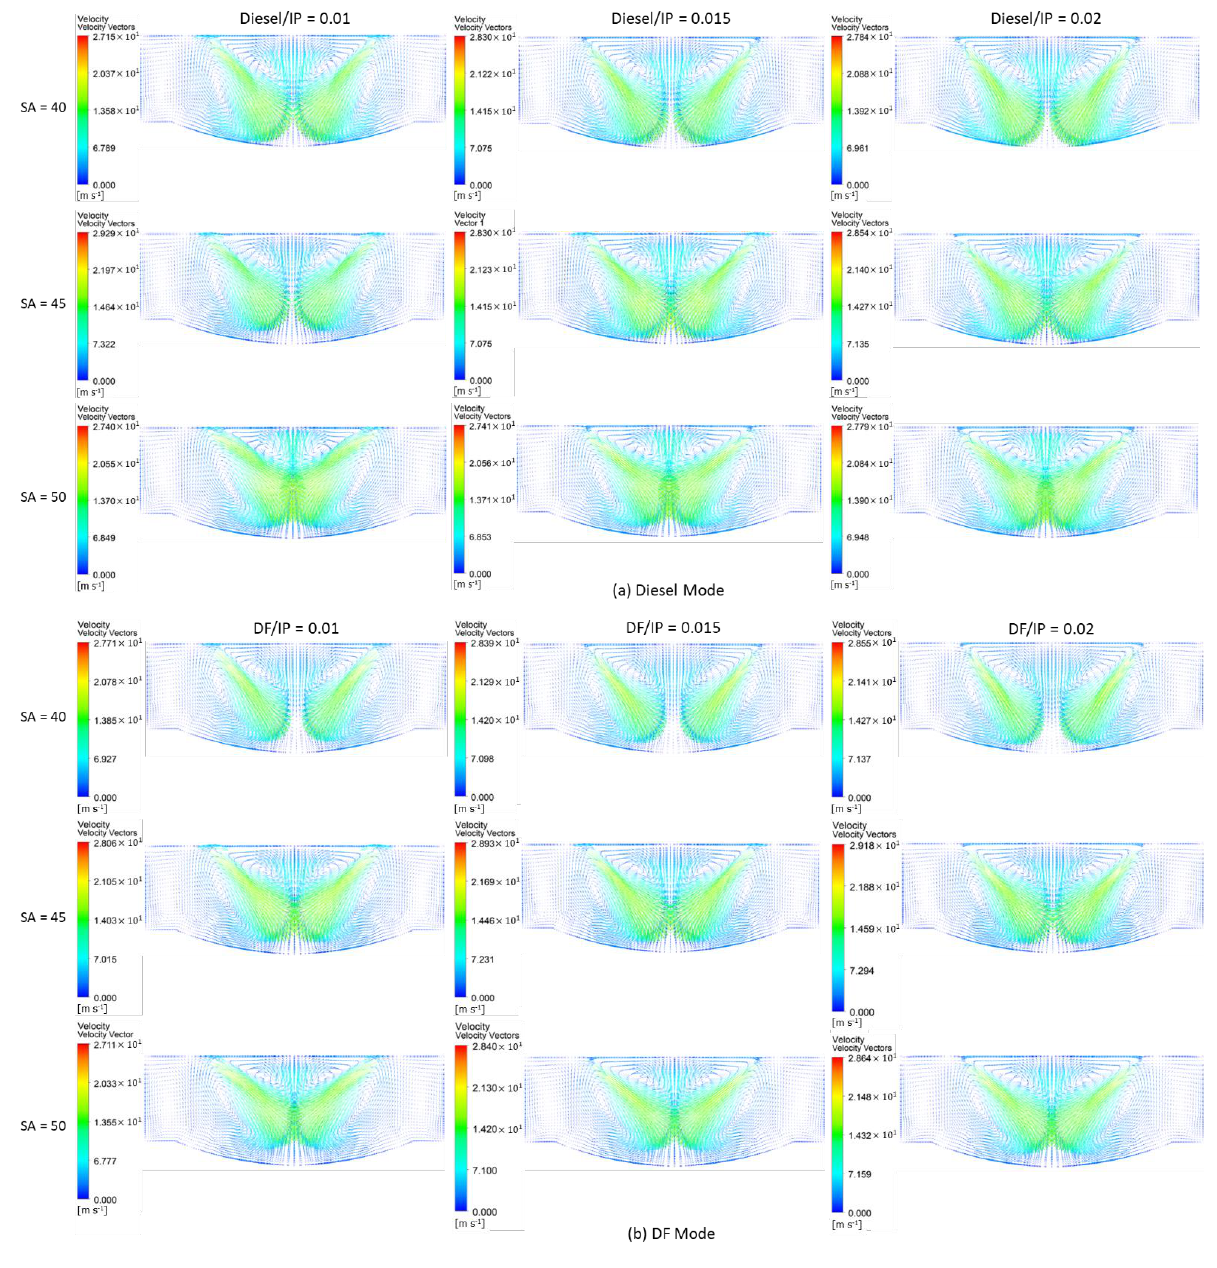
Figure 7. Velocity vectors in the engine cylinder at the TDC in all simulation cases with various SA and IP: ( a ) Diesel modes, ( b ) DF modes. and IP: ( a ) Diesel modes, ( b ) DF